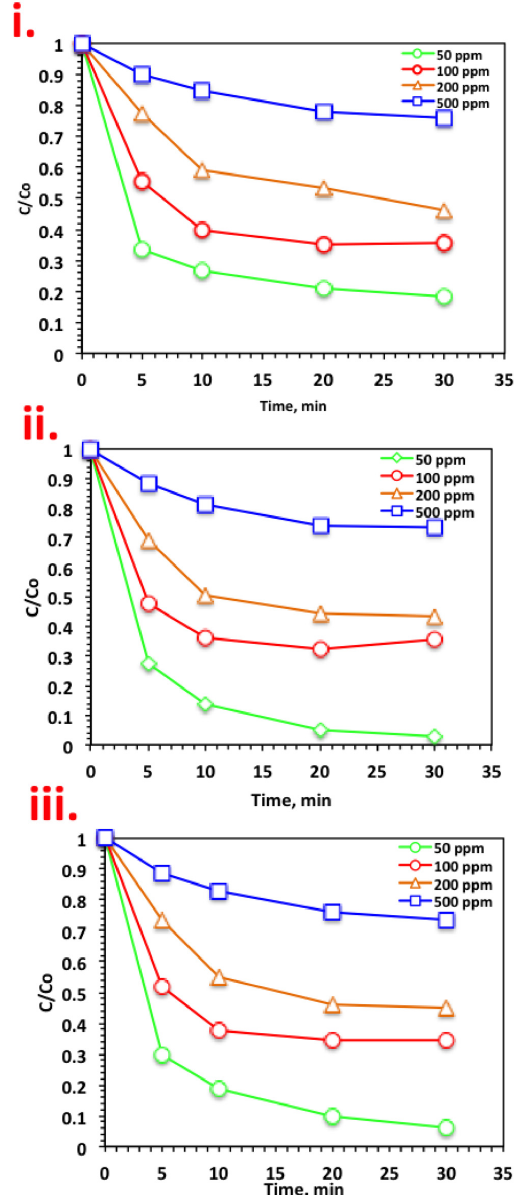
Figure 5. Effect of Nudrin loading on different systems: ( i ) WSD-based Fenton; ( ii ) Mag-based Fenton, and ( iii ) WSD:Mag composite-based Fenton.